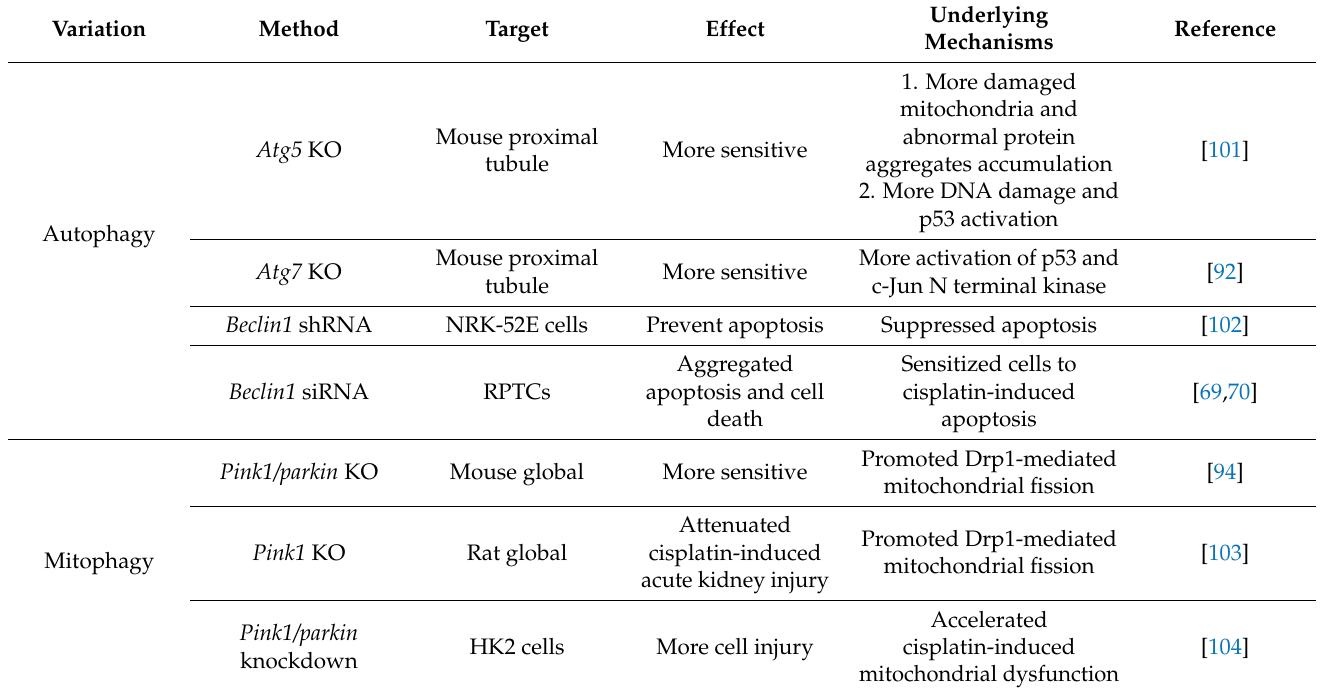
Table 1. Effects of ablation of autophagy genes on cisplatin-induced